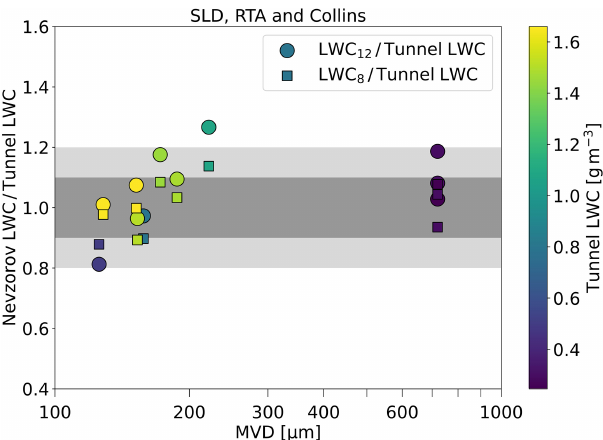
Figure 7. Measurements of the 12mm cone and the 8mm cone in comparison to the tunnel LWC in unimodal SLD conditions. The tunnel LWC is based on WCM-2000 measurements for all the FZDZ test points and on the IKP for the FZRA test